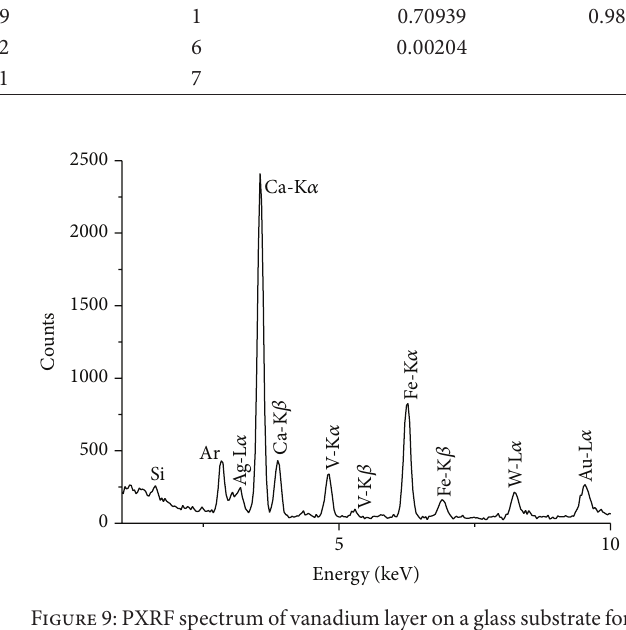
Figure 9: PXRF spectrum of vanadium layer on a glass substrate for the thickness of 185.7 nm. Measurement time 300 s.